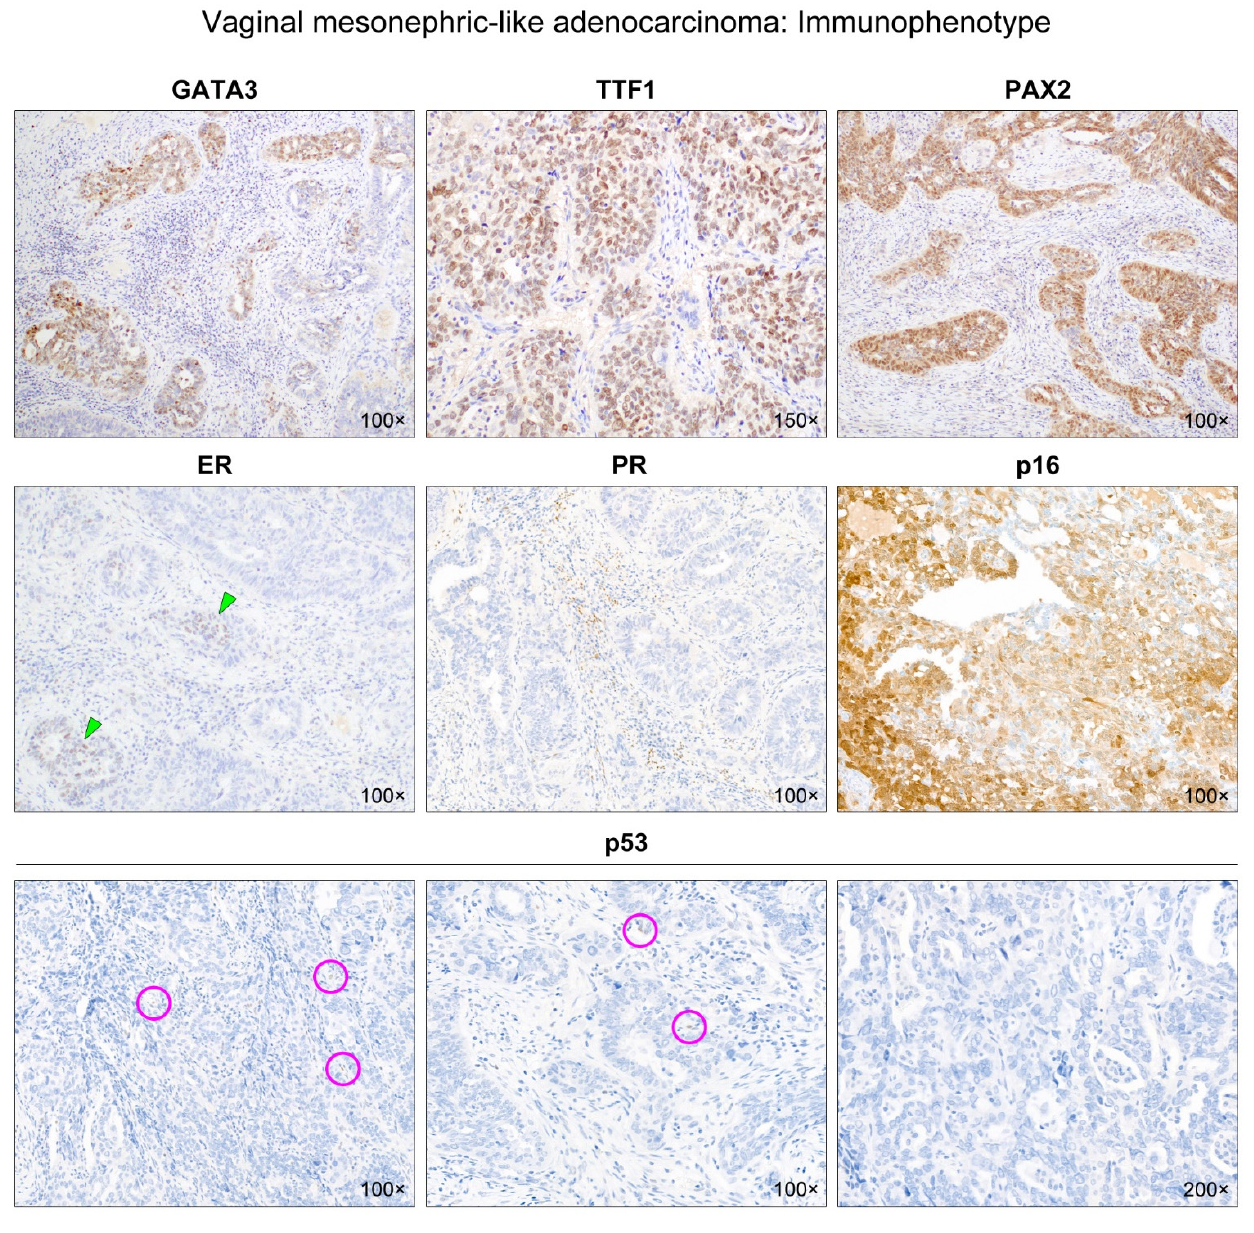
Figure 3. Immunophenotype of vaginal mesonephric adenocarcinoma. We conducted immunostaining for mesonephric markers (GATA-binding protein 3 [GATA3], transcription termination factor 1 [TTF1], paired box 2 [PAX2]), and hormone receptors (estrogen receptor [ER] and progesterone receptor [PR]) p16 and p53. The tumor expressed three mesonephric markers: GATA3, TTF1, and PAX2. The tumor cells were focally positive for GATA3 with moderate staining intensity. TTF1 and PAX2 were diffusely expressed in most of the tumor cells with moderate-to-strong staining intensity. In contrast, ER immunoreactivity was very weak in a few neoplastic glands (green arrowheads), and PR expression was completely absent. p16 positivity was patchy with variable staining intensity. All of the tumor cells exhibited a complete lack of p53 immunoreactivity (mutant p53 expression pattern). A few scattered inflammatory cells and stromal cells showing weak nuclear p53 expression served as positive internal controls (purple circles).